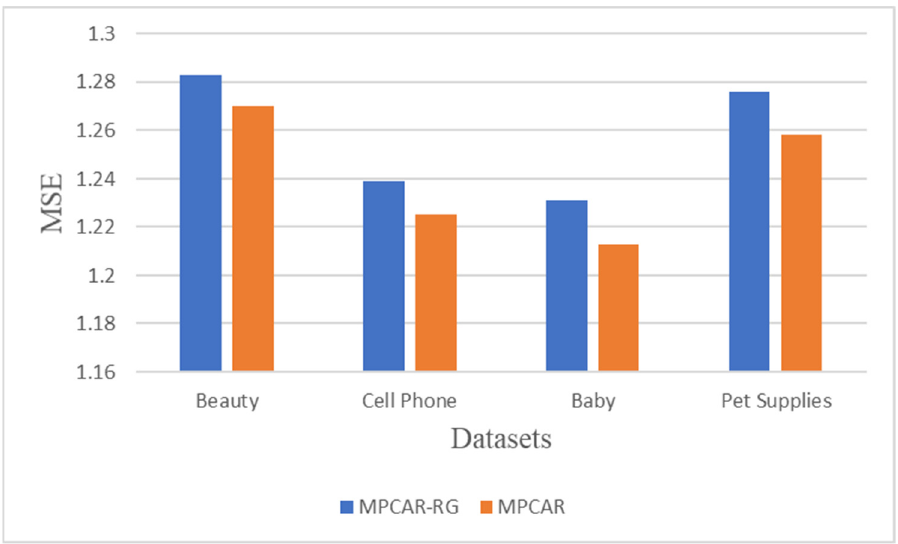
Figure 6. MPCAR-RG and MPCAR comparison results.